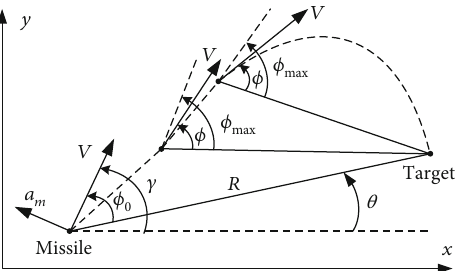
Figure 1: Engagement geometry for stationary target with fi eld-of- view